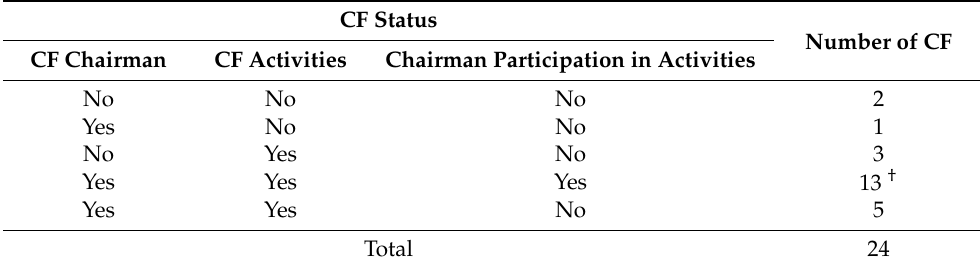
Table 2. Characteristics of 24